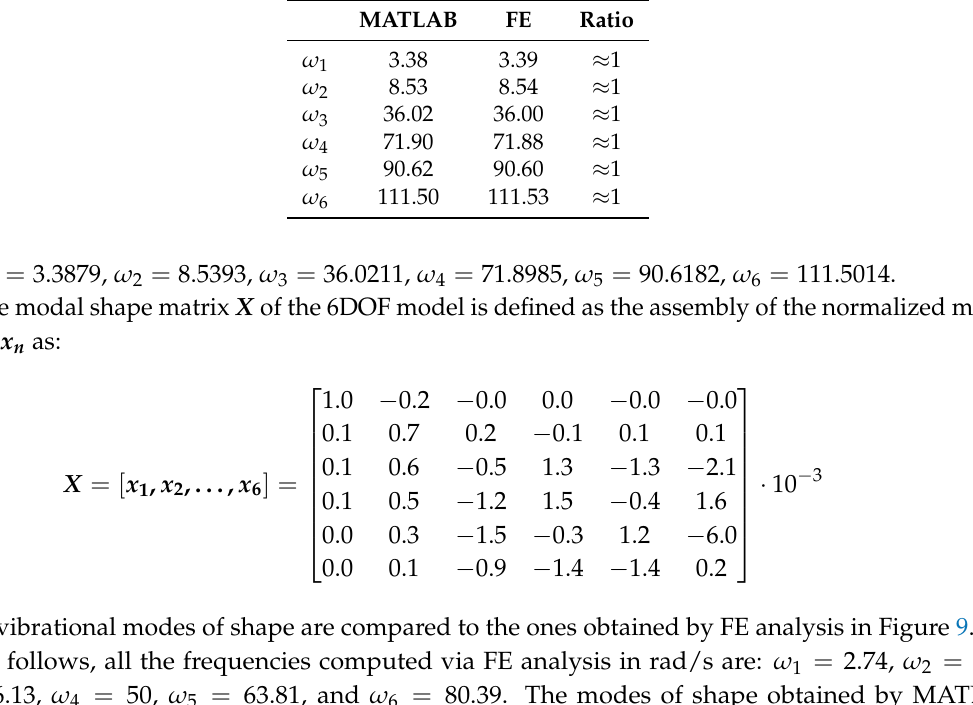
Table 2. Undamped natural frequencies computed using MATLAB and the FE model.